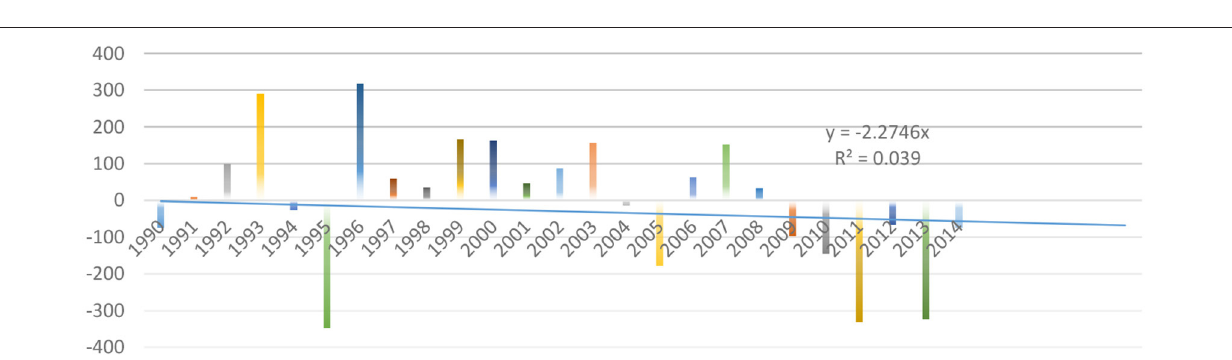
FIGURE 3 | Observed Rainfall trend and anomalies in Fundong. Source: DDARD for Fundong